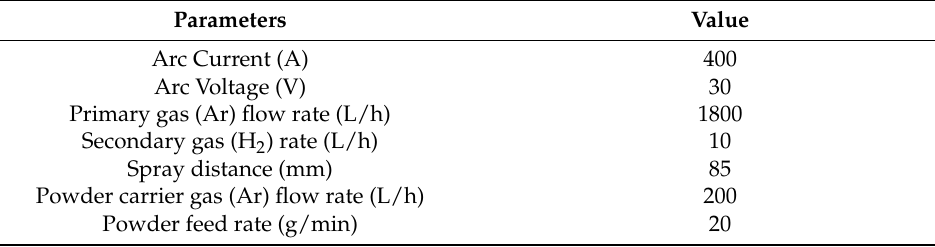
Table 1. Atmosphere plasma spraying parameter.